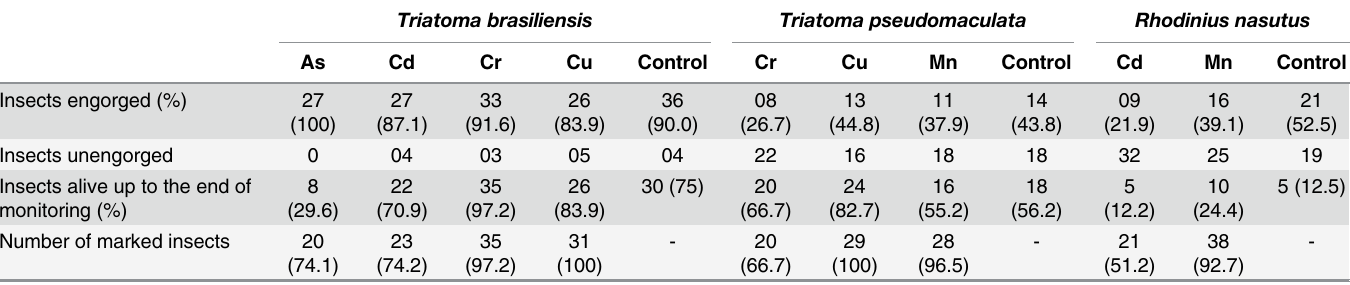
Table 2. Number of Triatoma brasiliensis , Triatoma pseudomaculata and Rhodnius nasutus nymphs blood fed with sheep blood containing trace elements or plain blood, number of insects alive up to the end of survival monitoring and persistence of